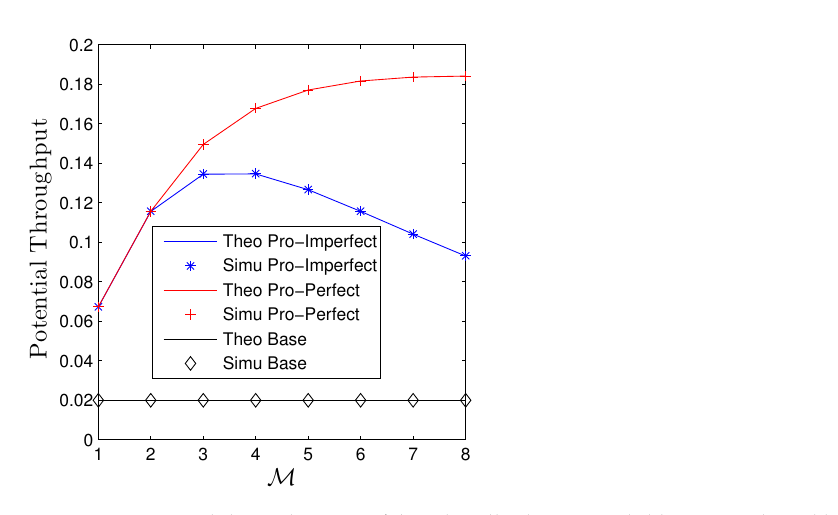
Figure 11. Potential throughput vs. M under all schemes. Solid lines are plotted by employing (13) while markers are Monte Carlo